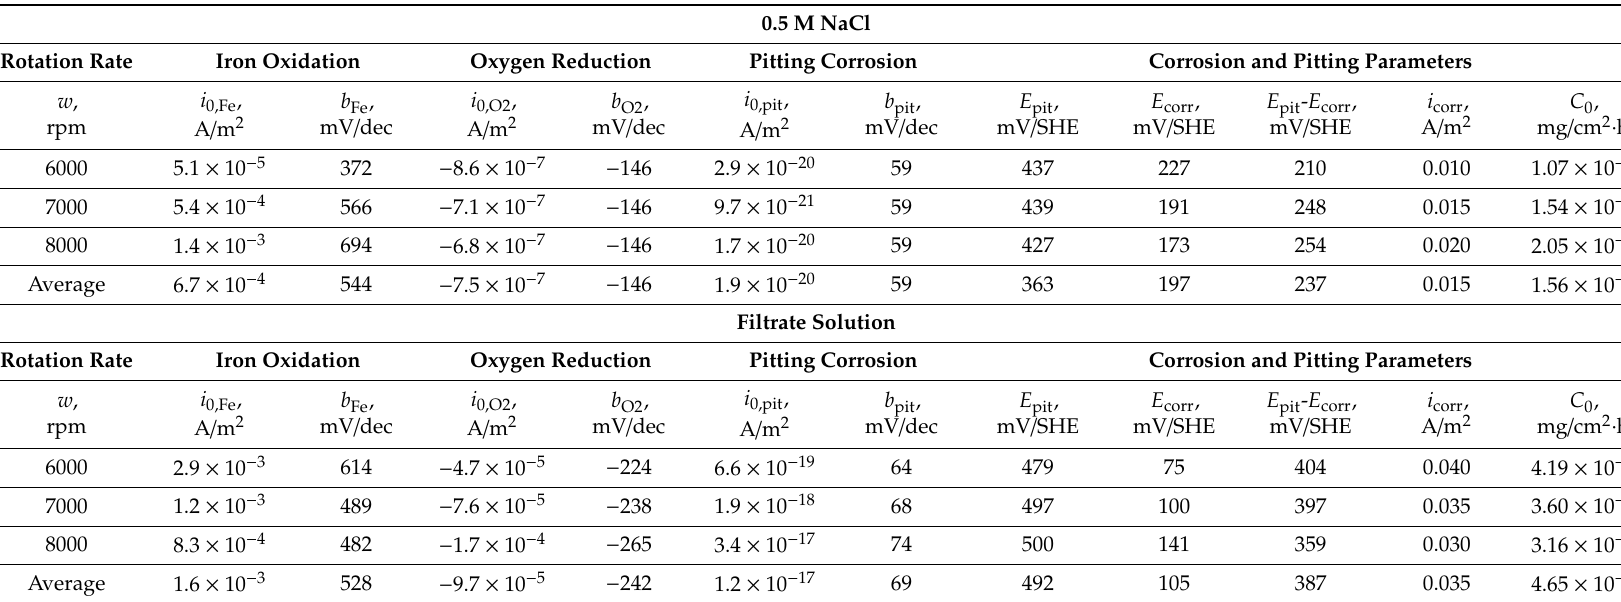
Table 1. Electrochemical and corrosion parameters for AISI 304L stainless steel in the 0.5 M NaCl and filtrate solution from tailings